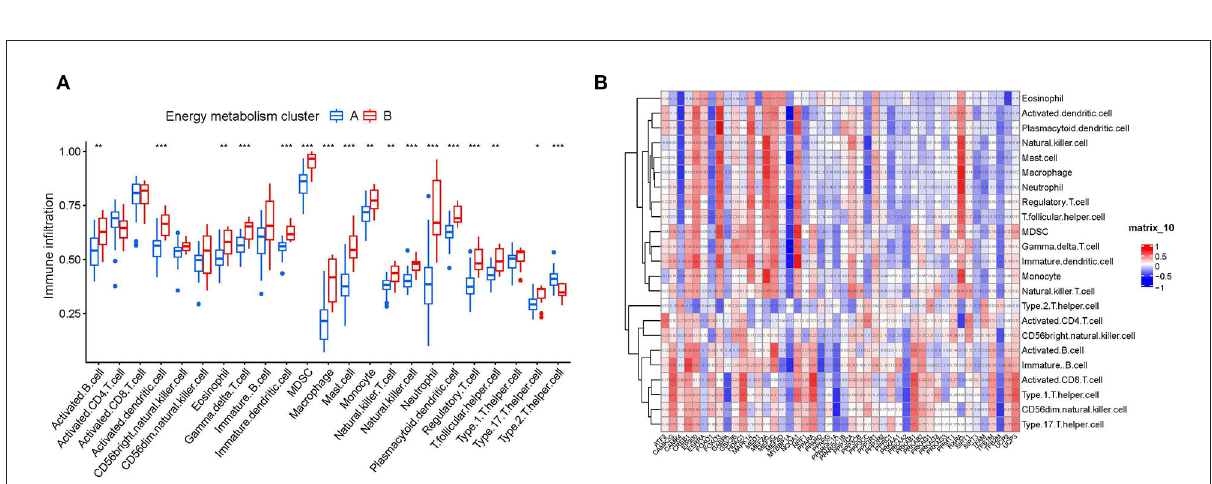
FIGURE4 Correlation analysis between energy metabolism-related genes and immune microenvironment. (A) The relationship between two clusters and the level of immune cell infiltration. * p -value < 0.05; ** p -value < 0.01; *** p -value < 0.001; **** p -value < 0.0001. (B) The relationship between 46 energy metabolism-related genes and immune cell